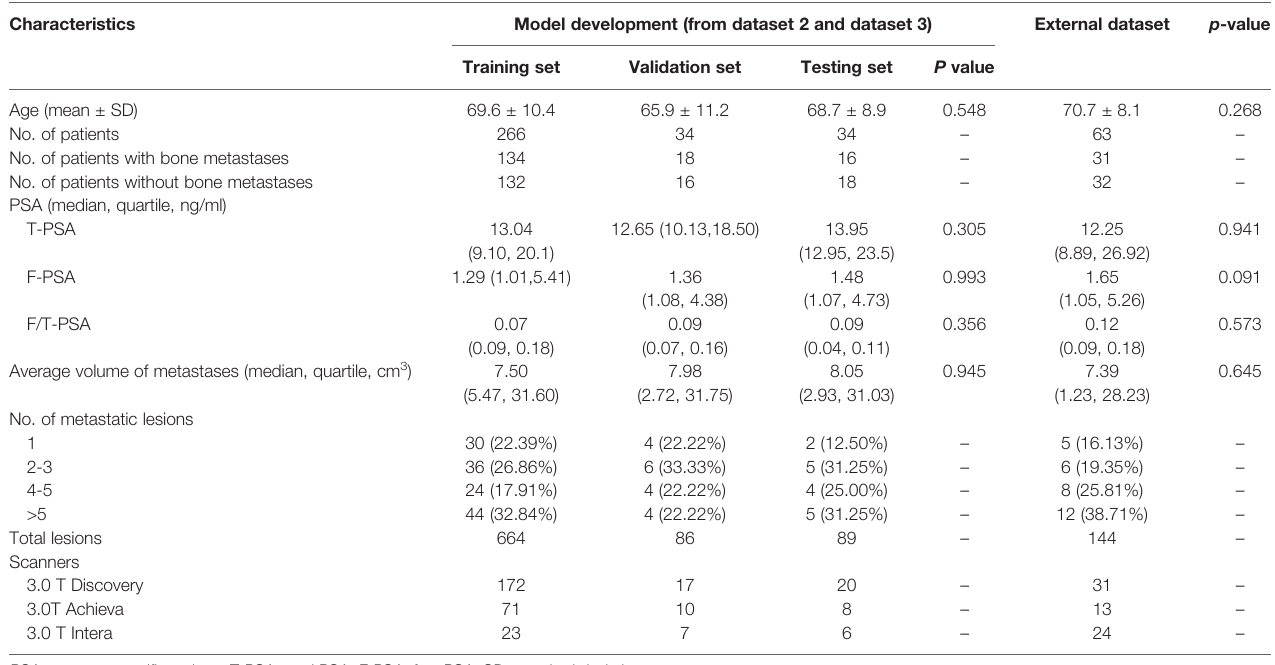
TABLE 3 | Characteristics of patients for the bone metastases